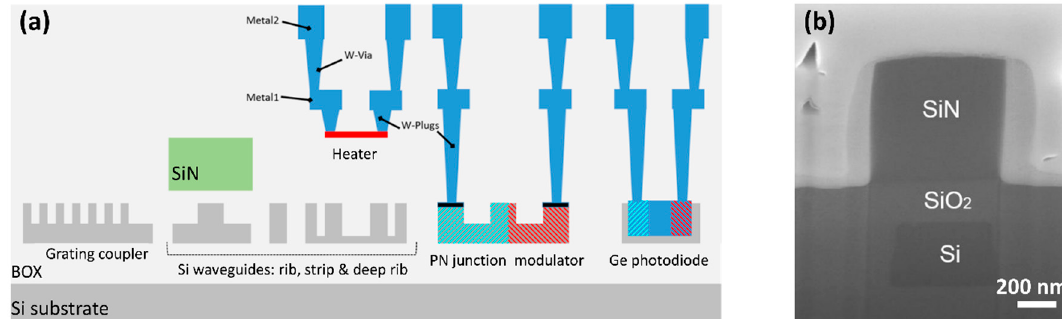
Figure 1. ( a ) Cross-section of the full Si-SiN platform based on SOI 300 nm (gray waveguides) and SiN (green waveguide), together with metallic heaters, PN modulator, Ge photodiode and metallic interconnection. The BOX is 2 µ m. ( b ) SEM cross-section view obtained by FIB cut of Si and SiN waveguides. Si is 300 nm thick, SiN is 600 nm thick. The interlayer SiO 2 thickness is 200 nm.